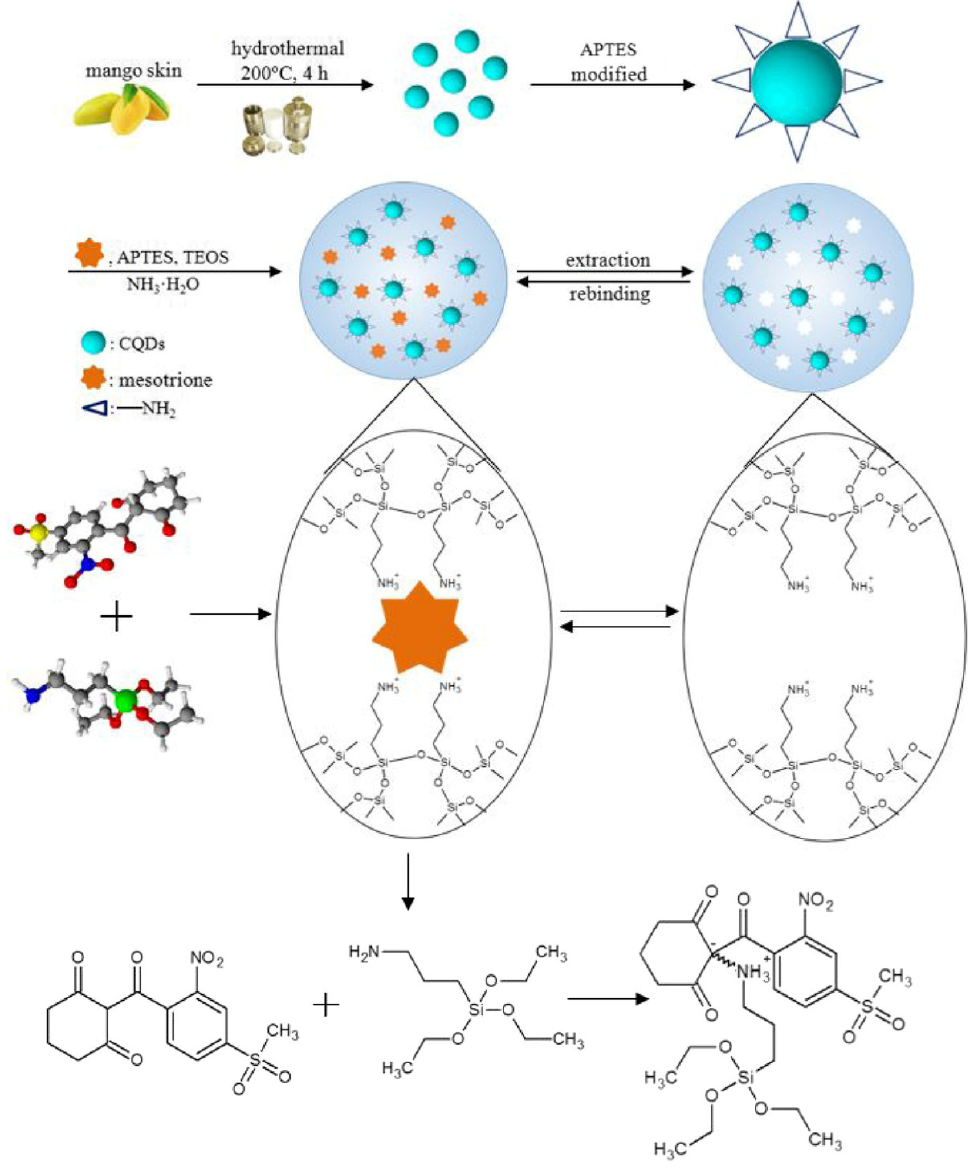
Figure 10. Synthesis preparation of CQDs@MIPs. Reproduced from the work in [108] with permission from Springer Na- ture.